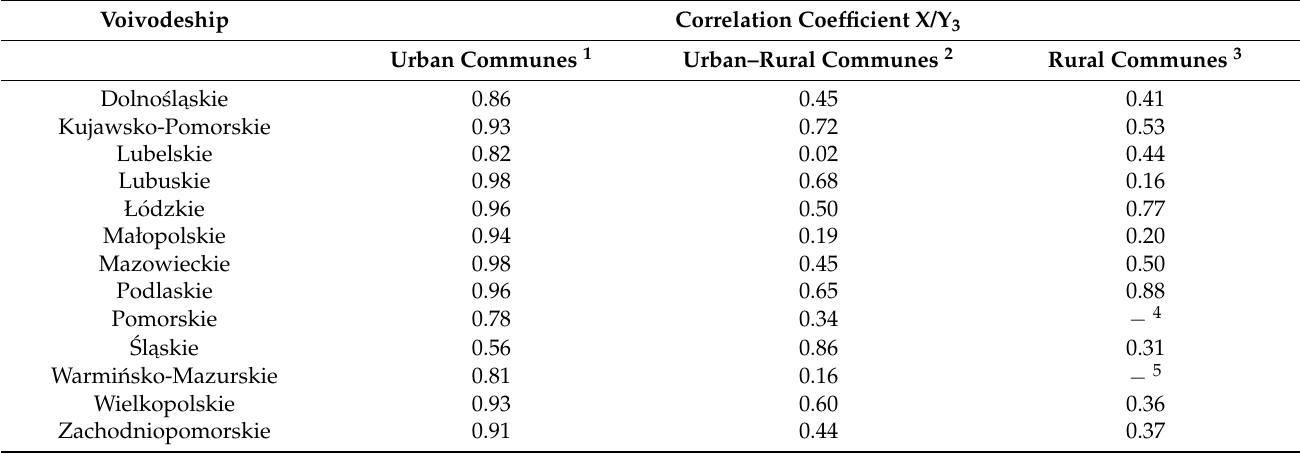
Table 14. Values of the correlation coefficient for the increase in the length of sewage networks and the number of inhabitants of the revitalised areas by the Voivodeship and type of the